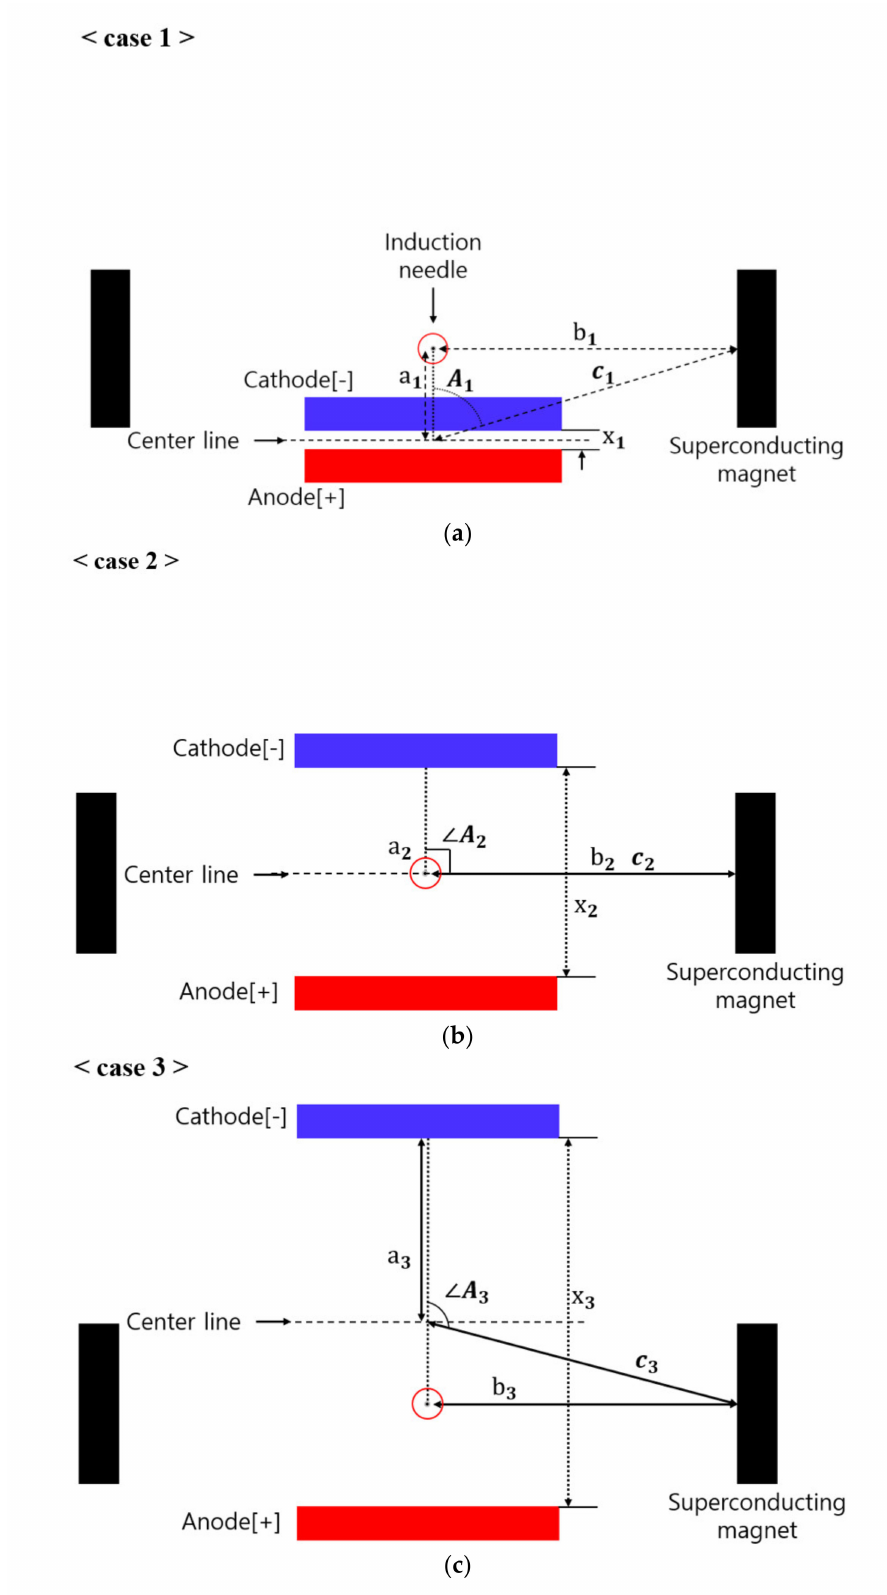
Figure 5. Mathematical indicators of arc-induction type DC circuit breakers according to the gap between the contacts ( a ) 0.5 mm, ( b ) 10 mm, ( c ) 30